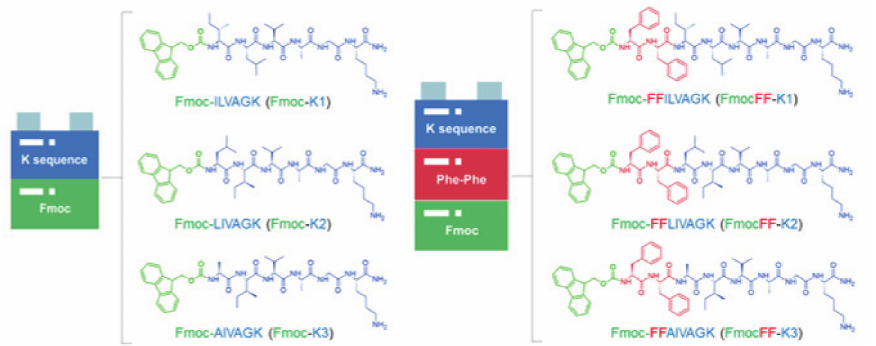
Figure 1. Schematic representation of Fmoc-K1, Fmoc-K2, and Fmoc-K3 peptides, and of their corresponding analogues containing the FF motif between the Fmoc protecting group and K1, K2, and K3 peptides. The sequences of the three peptides are reported in the figure according to the one letter